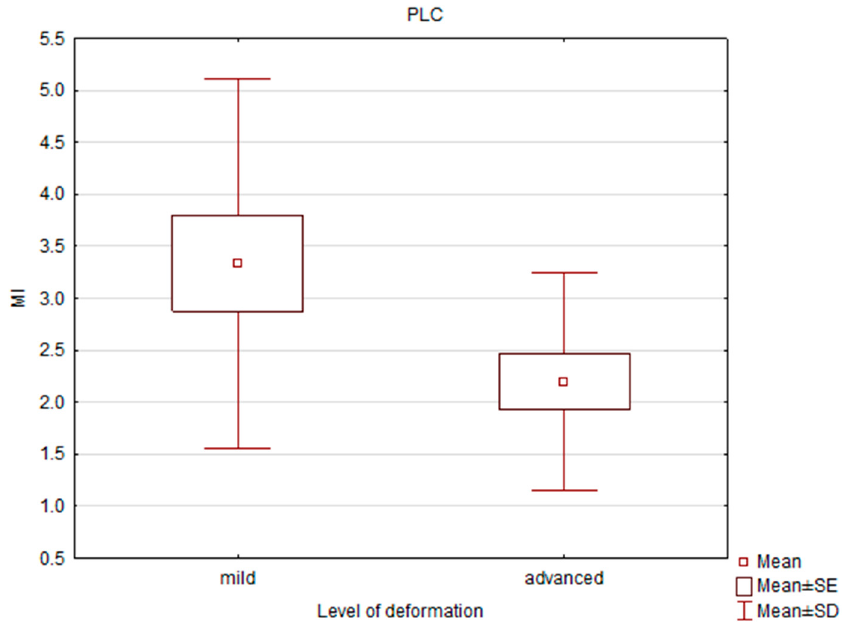
Figure 10. Box and whisker plot of the mineralization index (MI) in patients with mild and advanced deformity in the posterior part of the lateral condyle. deformity in the posterior part of the lateral condyle.